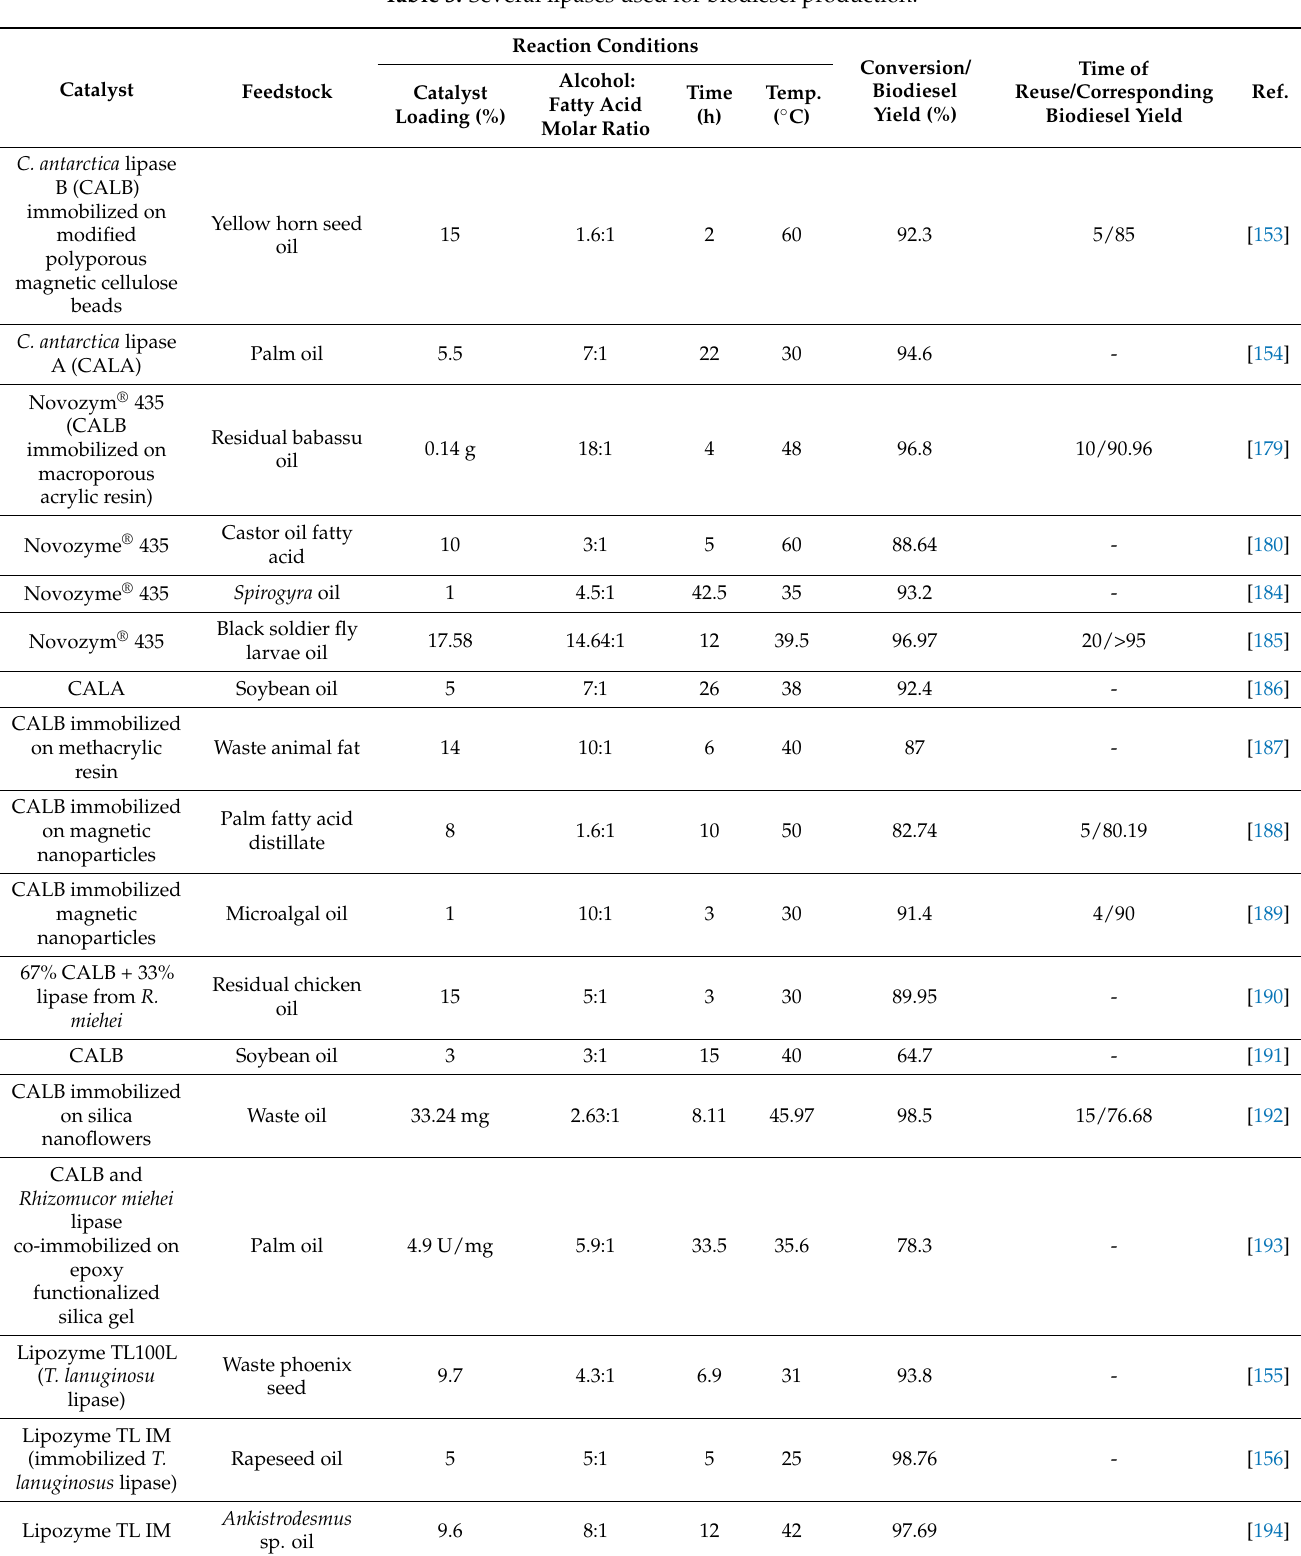
Table 3. Several lipases used for biodiesel